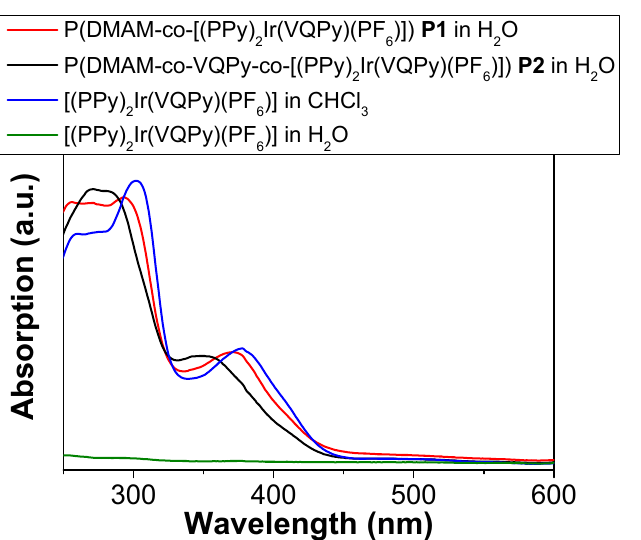
Figure 3. UV-Vis absorption spectra of the copolymers P(DMAM-co-[(PPy) 2 Ir(VQPy)(PF 6 )]) P1 , P(DMAM-co-VQPy-co-[(PPy) 2 Ir(VQPy)(PF 6 )]) P2 , in aqueous solution and of the complex [(PPy) 2 Ir(VQPy)(PF 6 )] in CHCl 3 and in water.